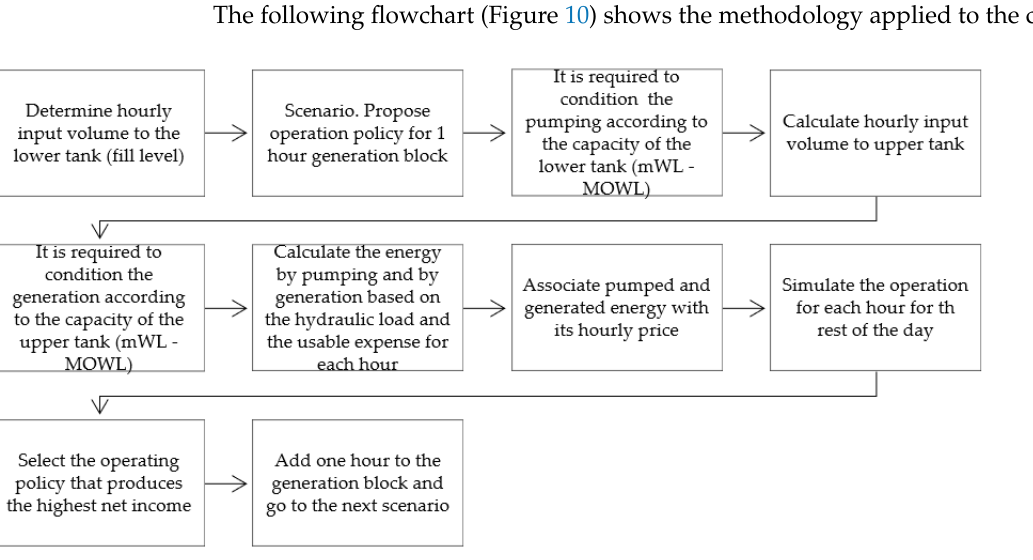
2019 due to the economic stagnation of the country.